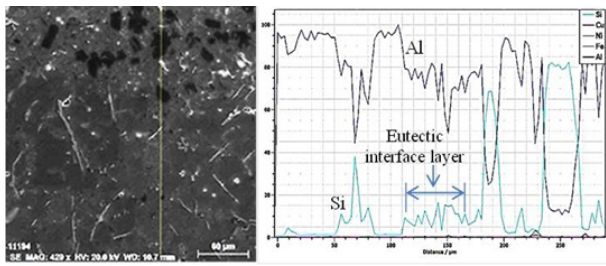
Figure 7. Interface elements’ line scan analysis of bimetal casting for a 10s time interval.